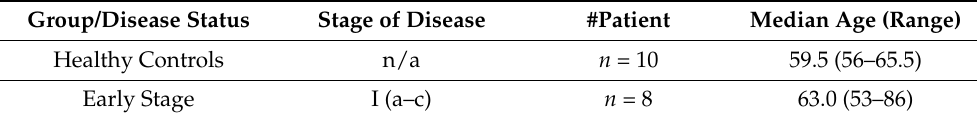
Table 1. Summary of Cohort #1.